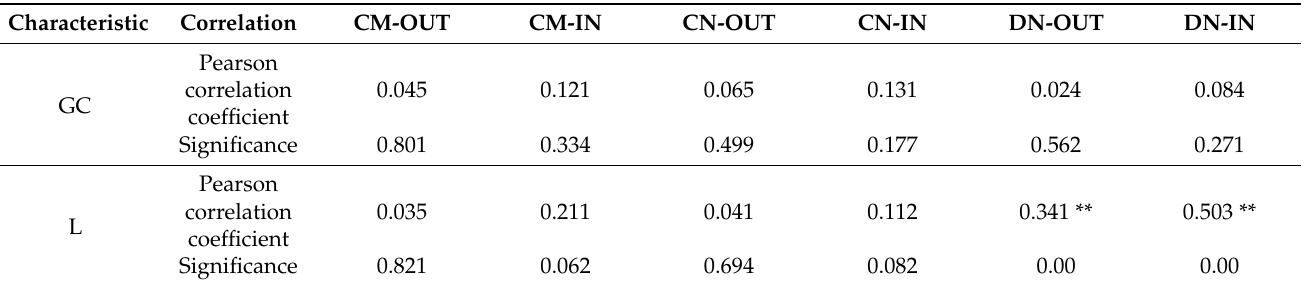
Table 1. The correlation between the degree (out and in), the characteristic path length and the giant component in CM, CN, and